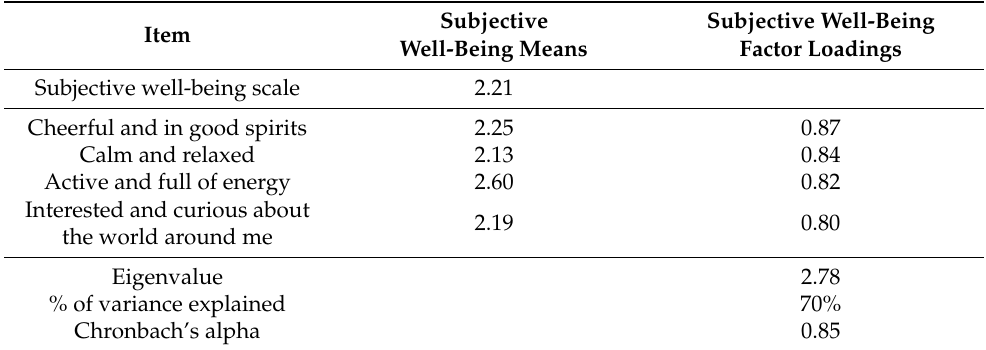
Table 1. Principal component factor analysis for pre COVID-19 pandemic subjective well-being items. Subjective Subjective Well-Being Item Well-Being Means Factor Loadings Subjective well-being scale 2.21 Cheerful and in good spirits 2.25 0.87 Calm and relaxed 2.13 0.84 Active and full of energy 2.60 0.82 2.19